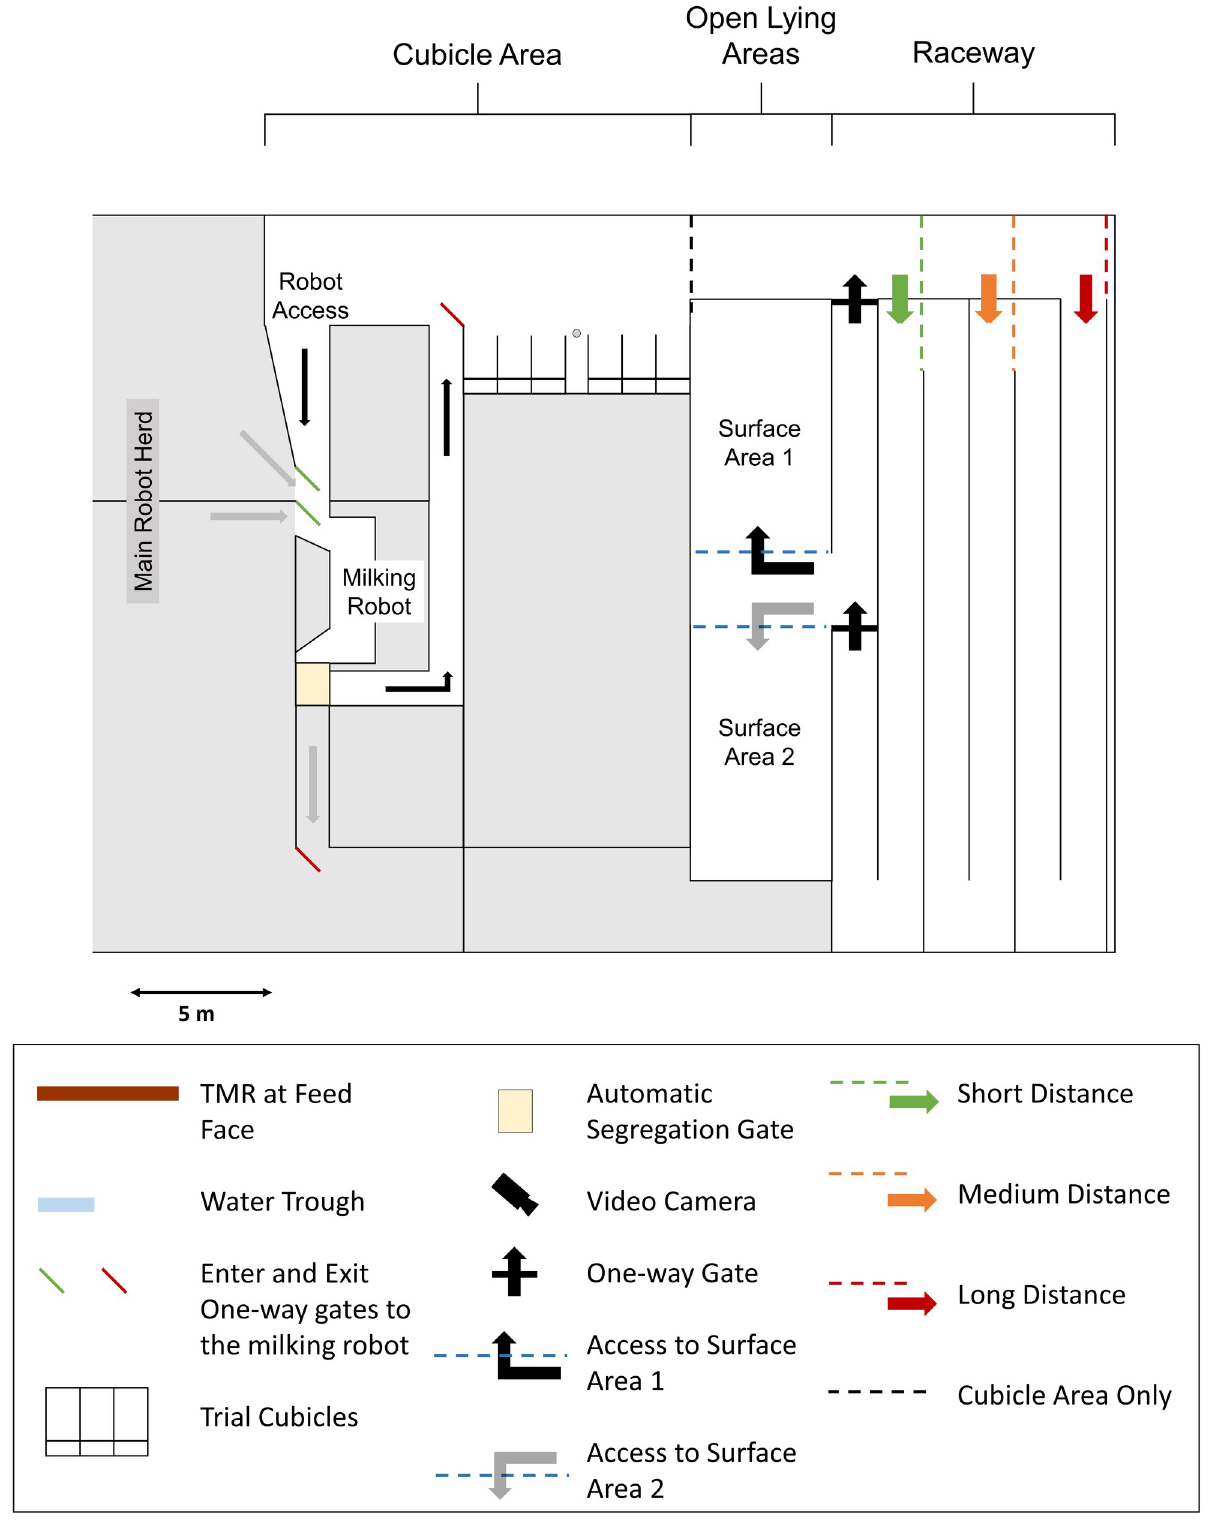
Fig 1. Plan of the trial area. The area is split into two main components; the ‘Cubicle Area’ and ‘Experimental Area’. Within the ‘Cubicle Area’ cows had access to six cubicles, feed face, a water trough and the milking robot. The ‘Experimental Area’ contained an indoor raceway which allowed access